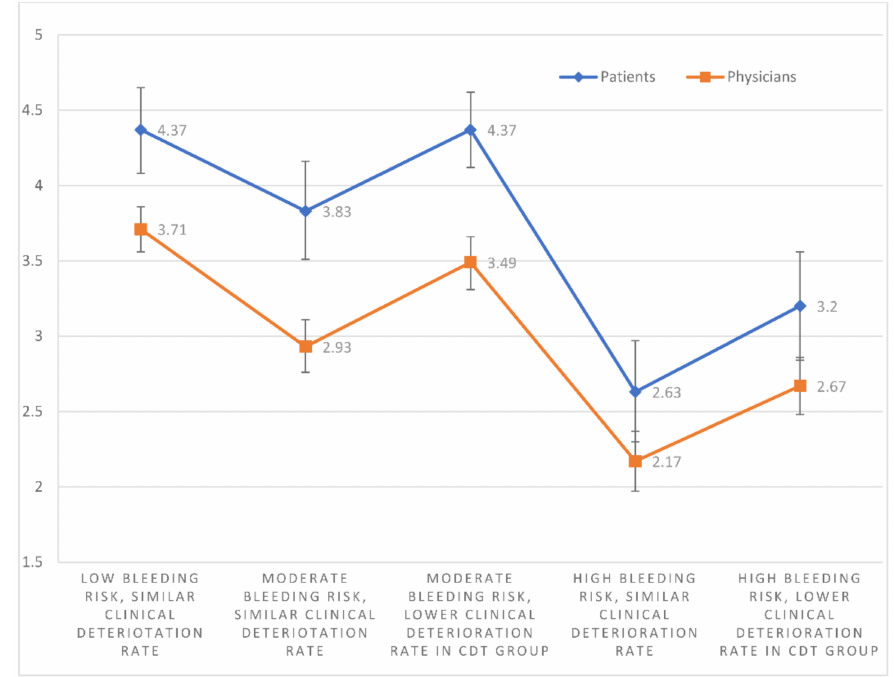
Figure 3. The mean CDT scores with 95% confidence intervals of physicians and patients for each individual